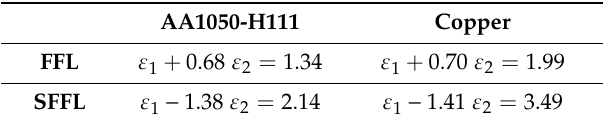
Table 5. Fracture loci for the fracture forming limit line (FFL) and shear fracture forming limit line (SFFL) of aluminium AA1050-H111 and copper sheets with 1 mm thickness.